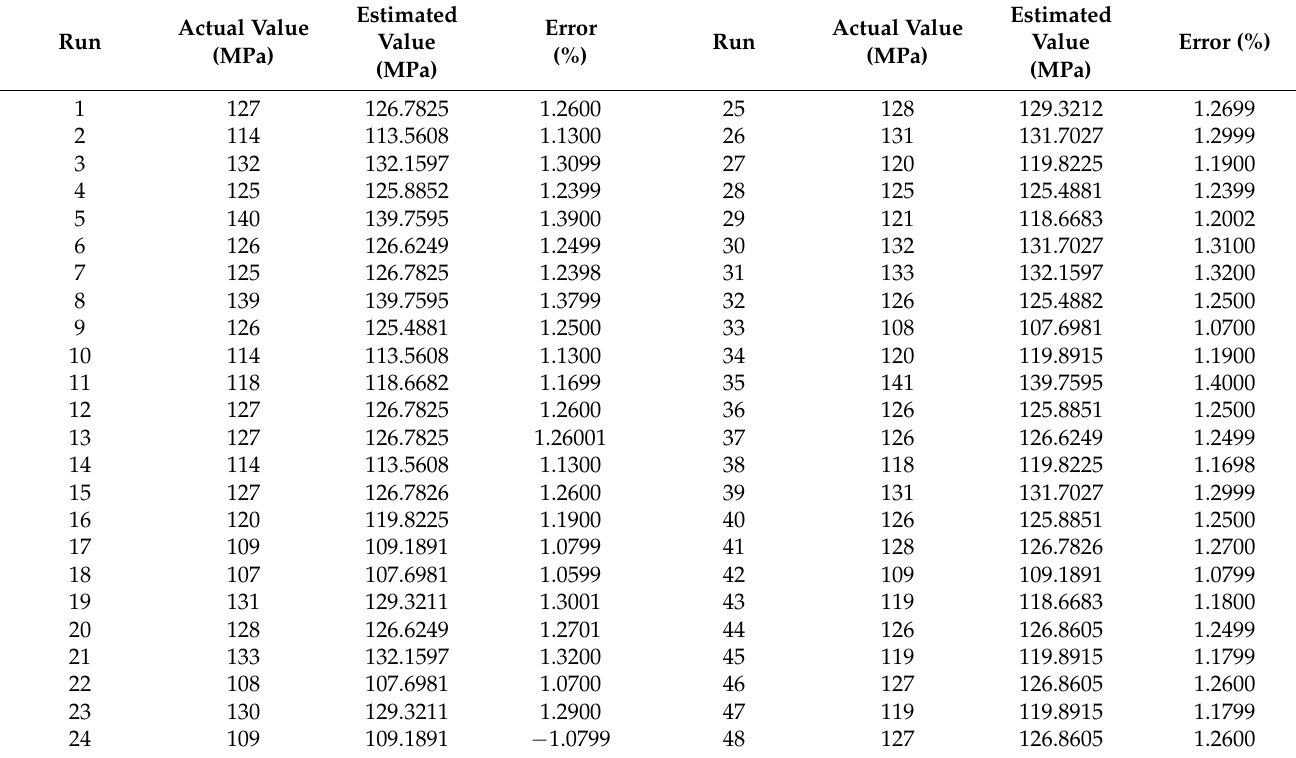
Table 2. Real and estimated values and error percentage at any treatment/repeat.